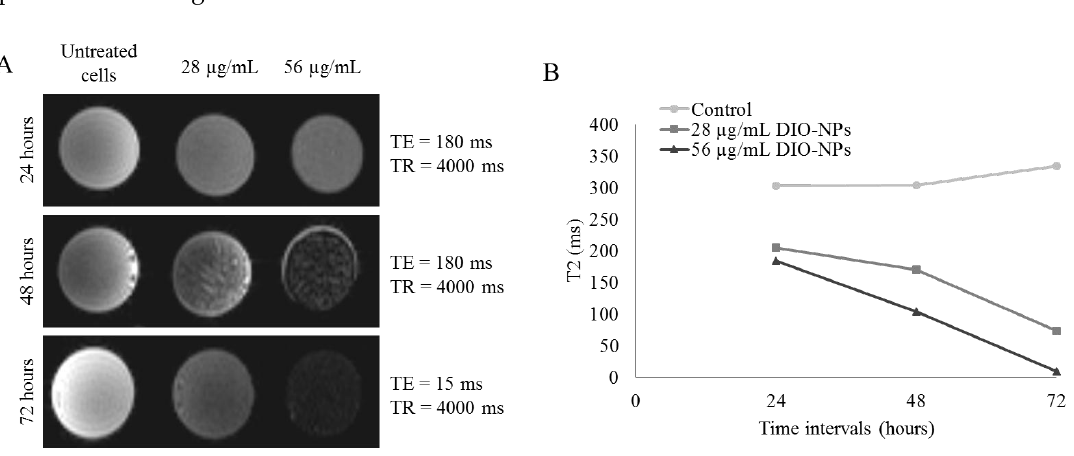
Figure 9. Effects of 28 and 56 µg/mL DIO-NPs exposure on ROS production ( A ), GSH content ( B ) and MDA level ( C ) in Jurkat cells. Values were calculated as percentage of treated cells compared to the control and expressed as means ± SD ( n = 3/experimental group). * p < 0.05 vs. control; ** p < 0.01 vs. control; *** p < 0.001 vs. control. In correlation with these results, we noticed a significant GSH depletion in Jurkat cells in the first two days of exposure to 56 µg/mL DIO-NPs (by 17% and 13%, respectively), followed by an